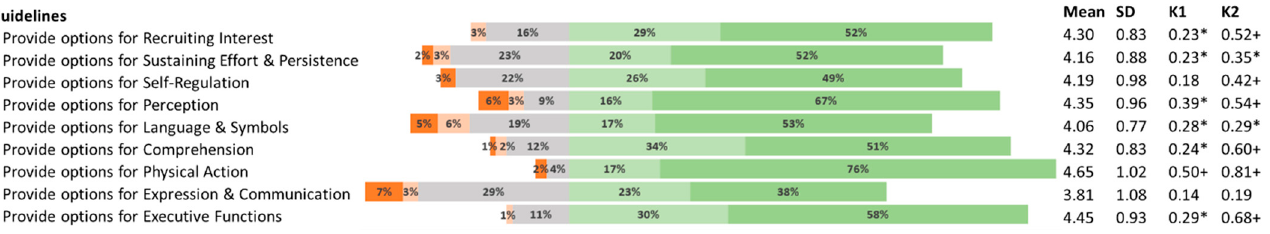
Figure 6. Guidelines evaluation results. Note: standard deviation (SD), Kappa for 5 values (K1); Kappa for 3 values (K2); fair agreement *; moderate, substantial, and perfect agreements +.